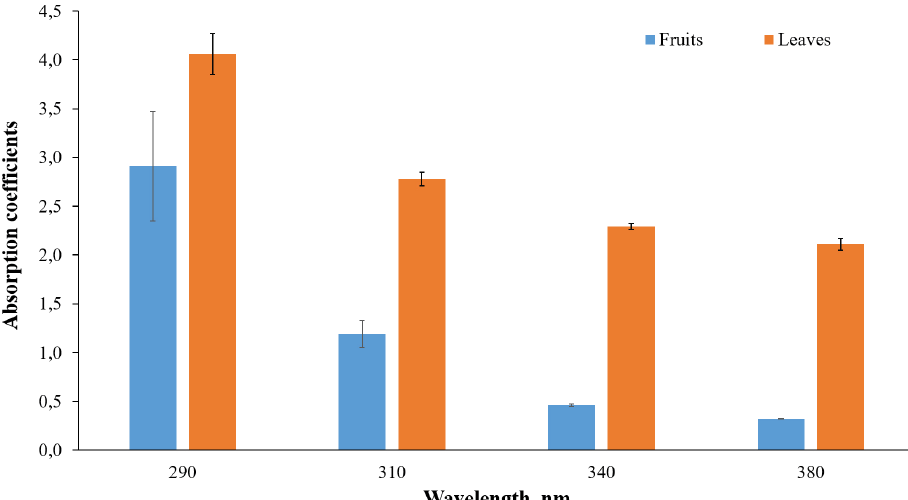
FIGURE 1 - UV spectrum of M. parvifolia extracts (at 0.019 mg/mL, all of them) and a mixed sample of benzophenone 3 (B3), butyl methoxydibenzoylmethane (BMDM), ethylhexyl methoxycinnamate (EHMC) (at 0.017 mg/mL, all of them).